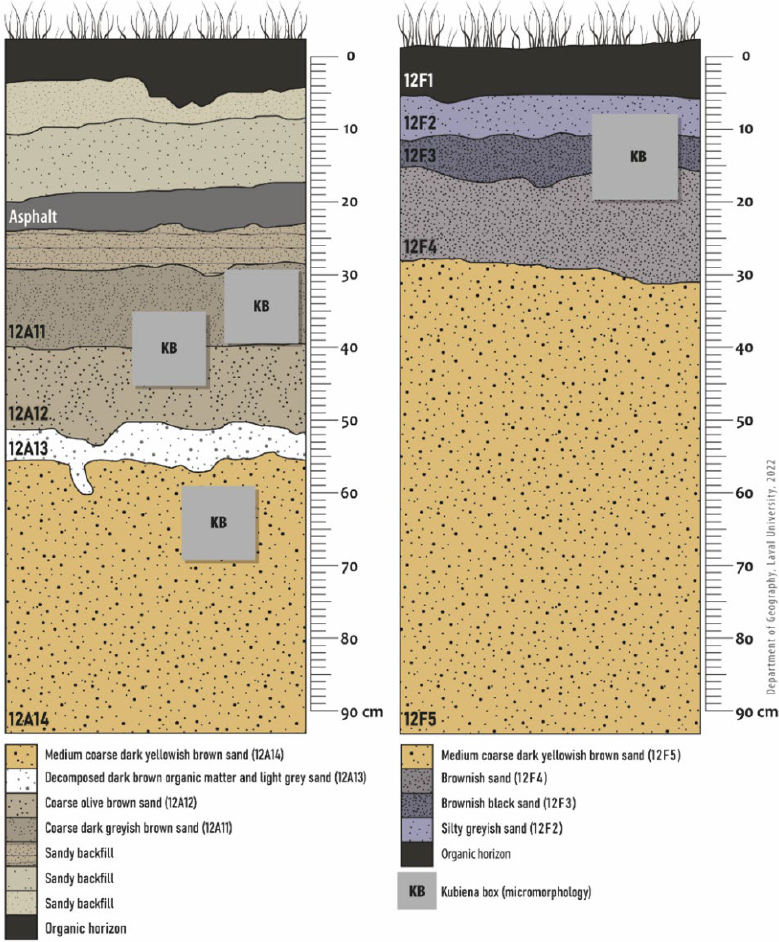
Figure 4. Stratigraphic position of sediment layers sampled in areas 12A and 12F of the Fort Odanak site (CaFe-7) (L. Marcoux, Université Laval, 2022). Table 1. Summary of the stratigraphic data from the Fort Odanak site (CaFe-7).